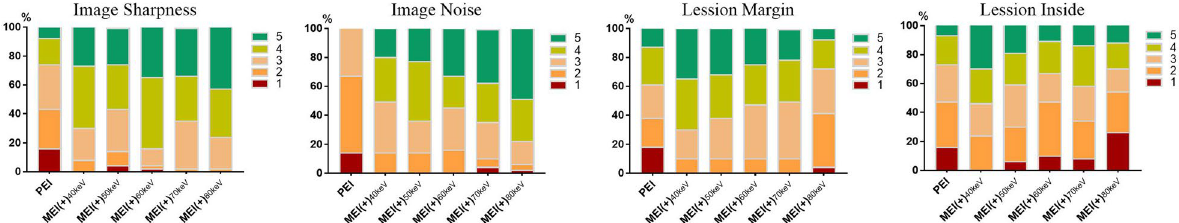
Fig. 2 Results of the subjective assessment. Image sharpness received significantly higher ratings in MEI ( image noise, the highest scores were assigned in MEI ( assessment of the lesion inside received the highest score in MEI (